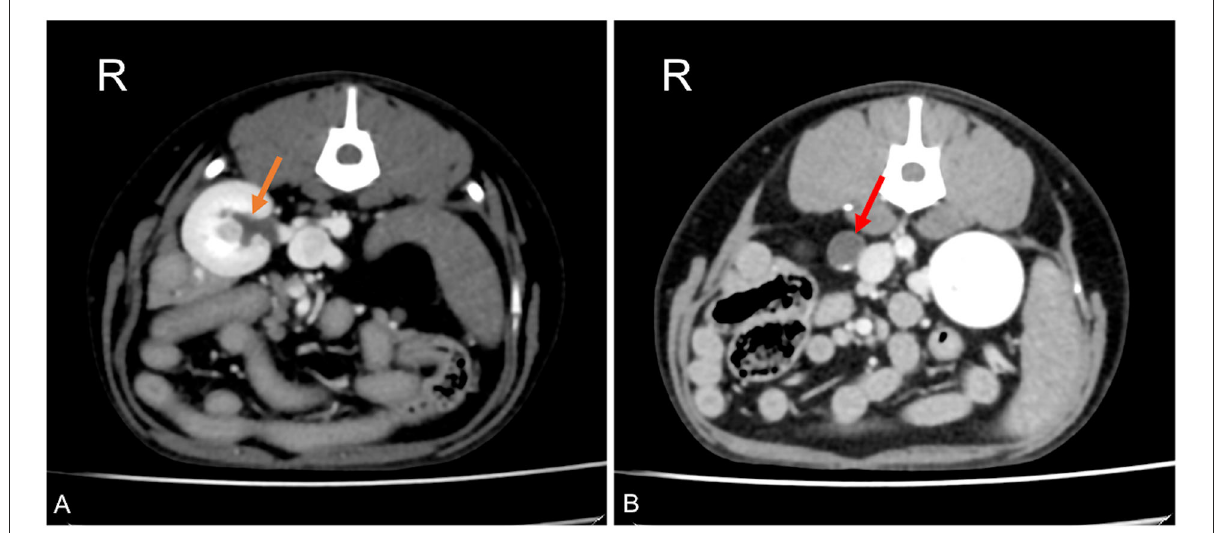
FIGURE2 Postcontrast computed tomographic images of mid abdomen in transverse views at the level of the right kidney (A) and just proximally to the venous ring (B) in a dog showing dilation of the renal pelvis (orange arrow) and dilation of the right ureter proximally to the venous ring malformation (red arrow). Soft tissue reconstruction (window level: 40 HU, window width 400 HU) and a slice thickness of 1.25mm were used. R,